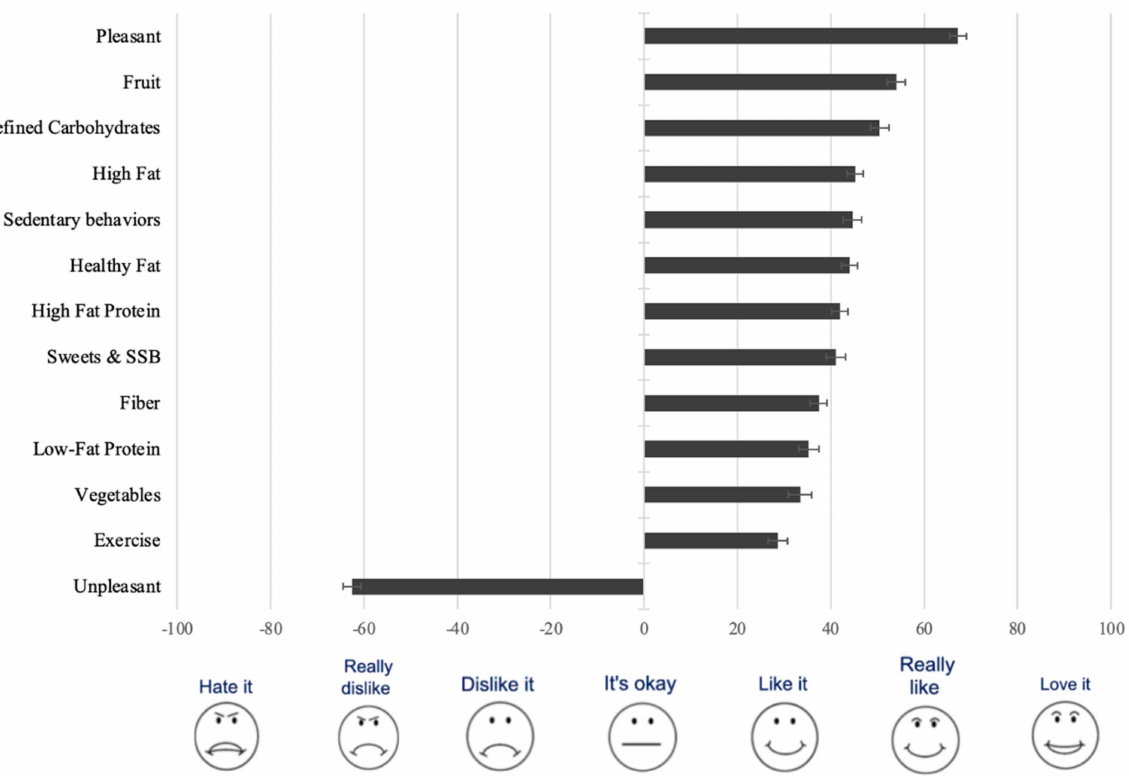
Figure 1. Average reported liking/disliking of foods and activities ( ± standard error of the mean) ranked most to least in adults (n = 276) from a low-income, low food access